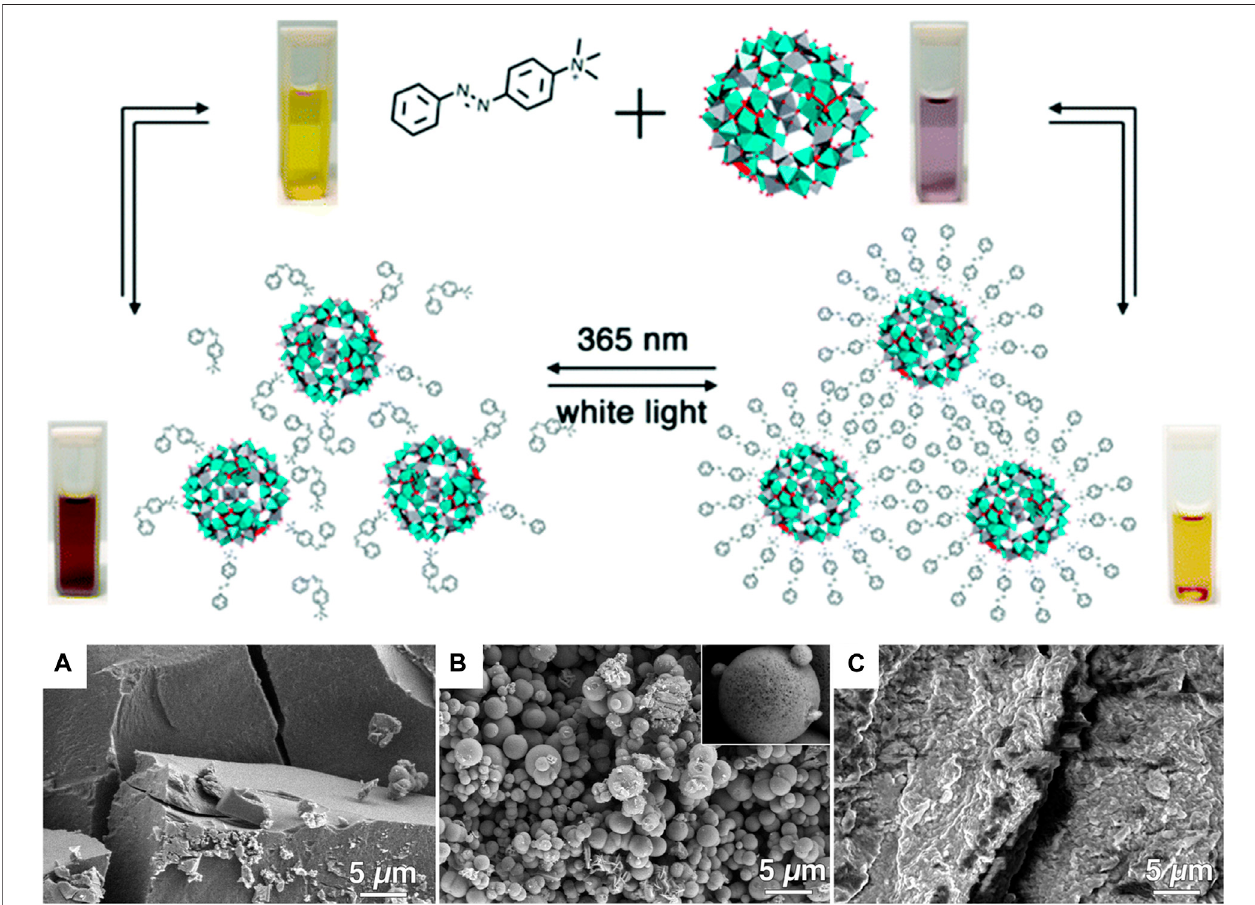
FIGURE 20 | {Mo 72 V 30 } – azo complex with irradiation dependent interconnection; top: schematic representation; bottom: SEM of dry fi lms prepared by drop- casting (A) {Mo 72 V 30 }beforefunctionalizationwithazomolecules; (B) the{Mo 72 V 30 }-trans-azohybridstructure; (C) {Mo 72 V 30 }-cis-azoobtaineduponUV-lightirradiation (365 nm) prior to drop-casting of the {Mo 72 V 30 }-trans-azo solution (Markiewicz et al., 2017). Reprinted with permission. Copyright © The Royal Society of Chemistry